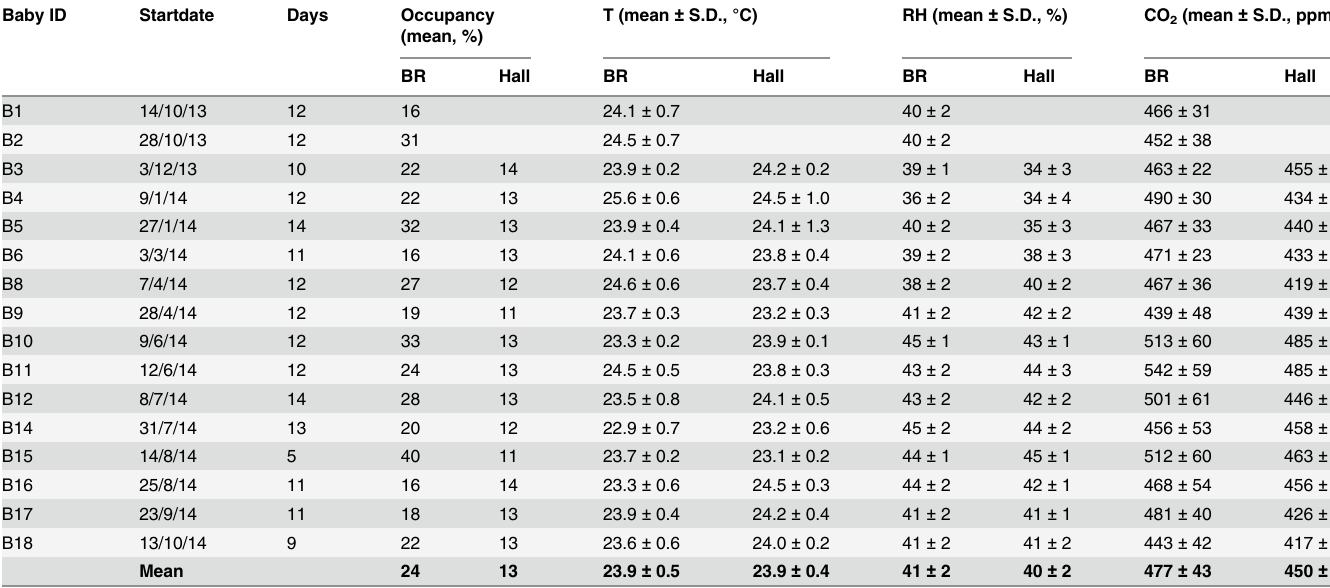
Table 1. Experimental schedule and year-long descriptive data of human occupancy load, dry-bulb temperature, relative humidity and carbon dioxide levels measured in baby rooms (BR) and hallway (Hall). 1 ,